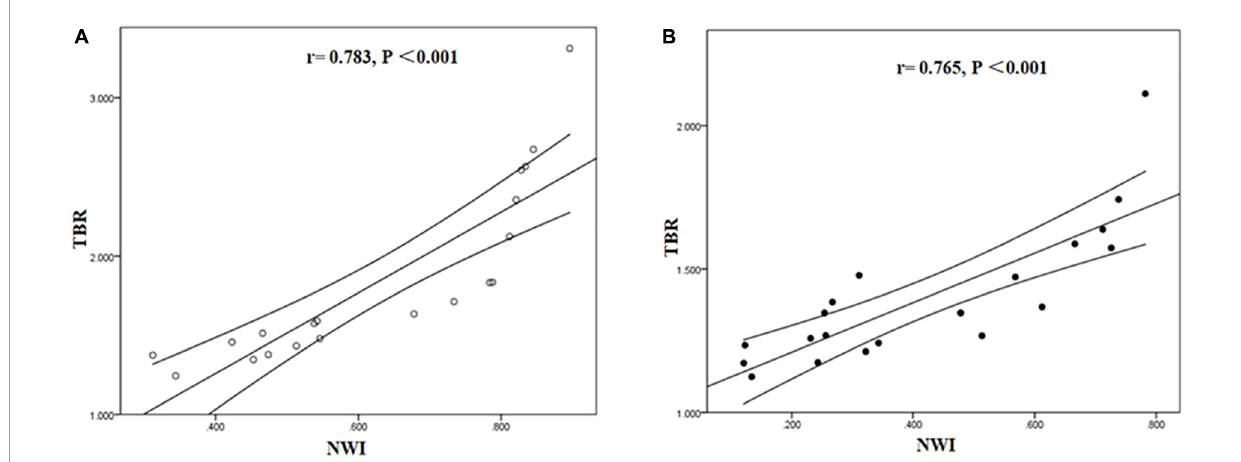
FIGURE6 Correlation between NWI and TBR in symptomatic and asymptomatic patients. The correlation between NWI and TBR values was significantly positive in symptomatic (A) and asymptomatic group (B)